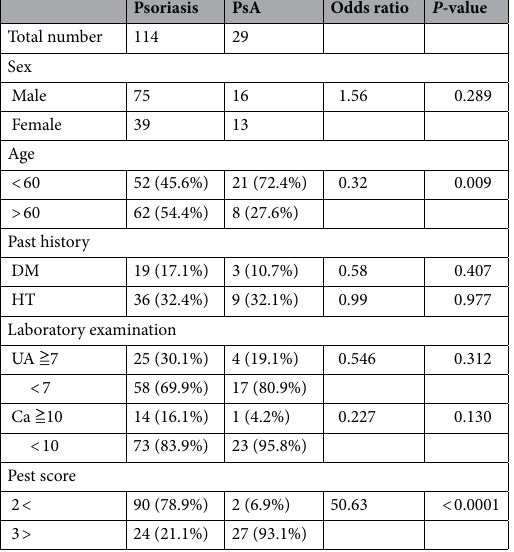
Table 2. Clinical characteristics of psoriasis and psoriasis arthritis. P -value was evaluated by Fisher exact test or Chi-square